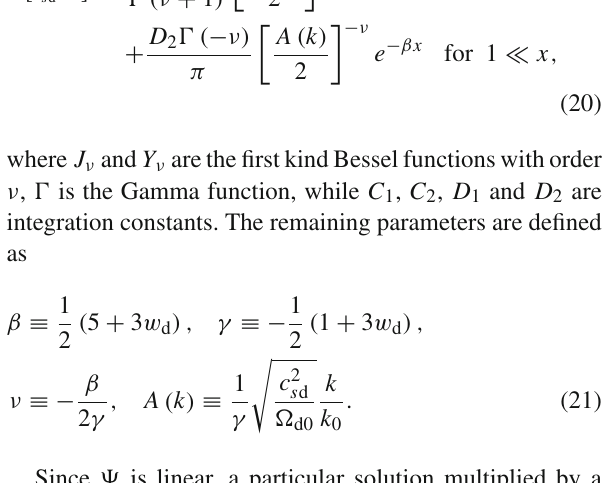
(cid:10) ∼ (cid:10) (cid:7) c 2 s d (cid:6)= 0